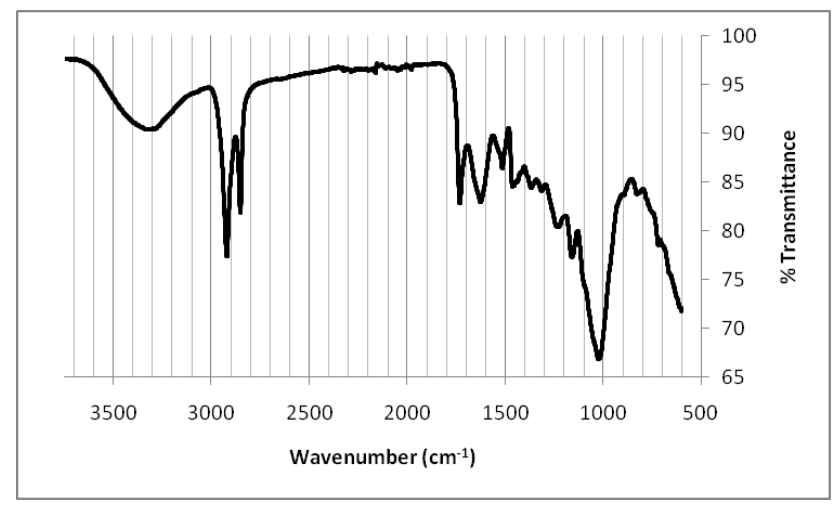
Figure 4. FTIR of SEGT (Soxhlet extracted green tea leaves).